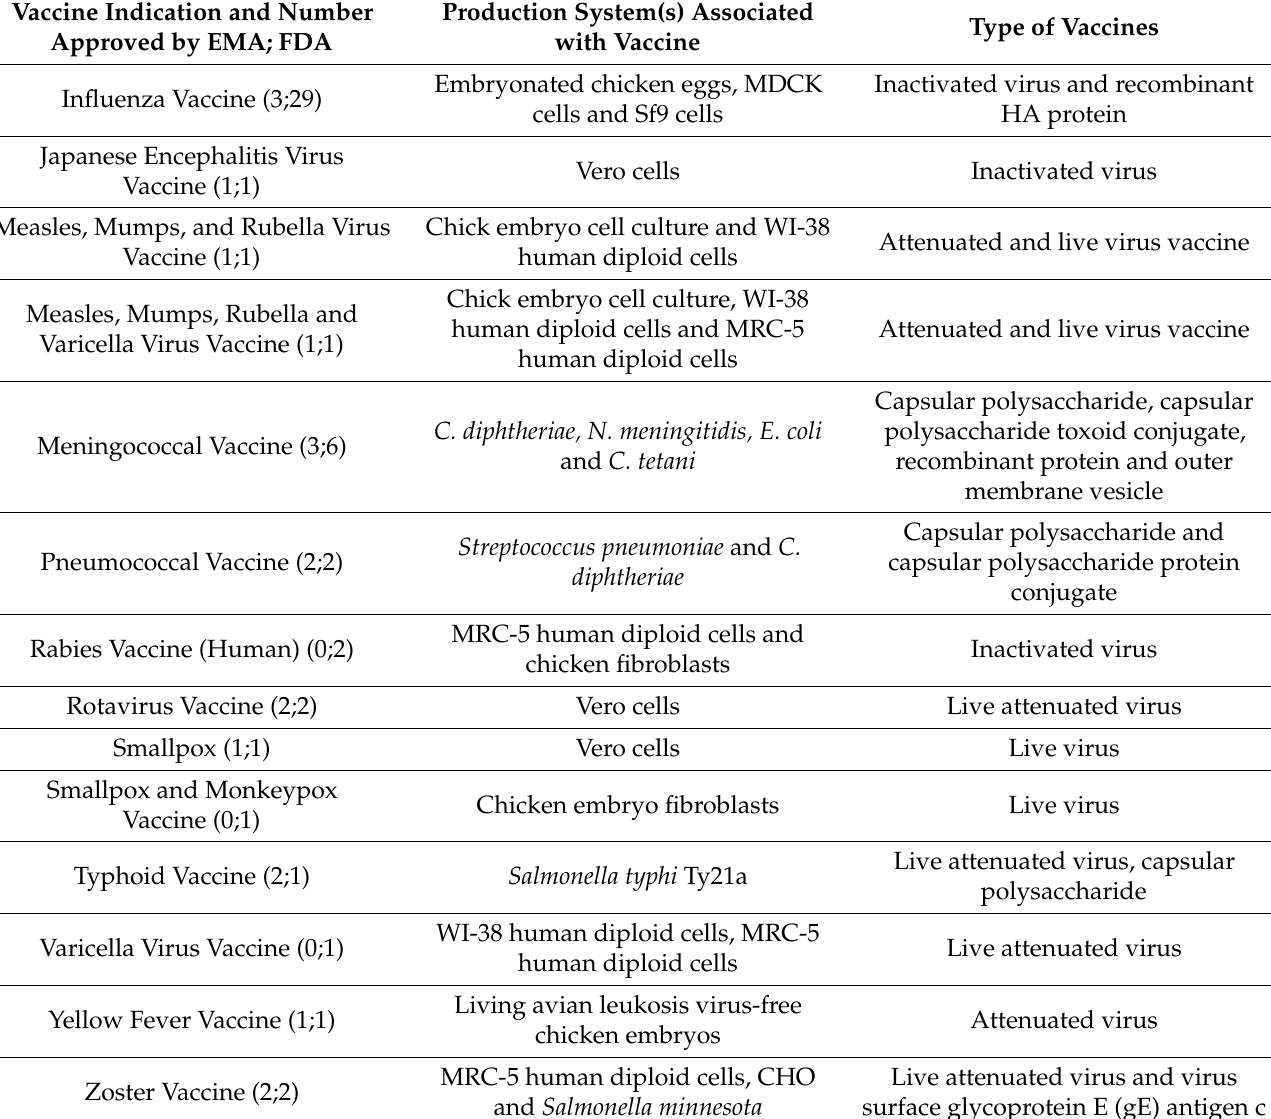
Table 3. European Medicines Agency (EMA) and FDA Approved Vaccines 2020 [70,71]. Vaccine Indication and